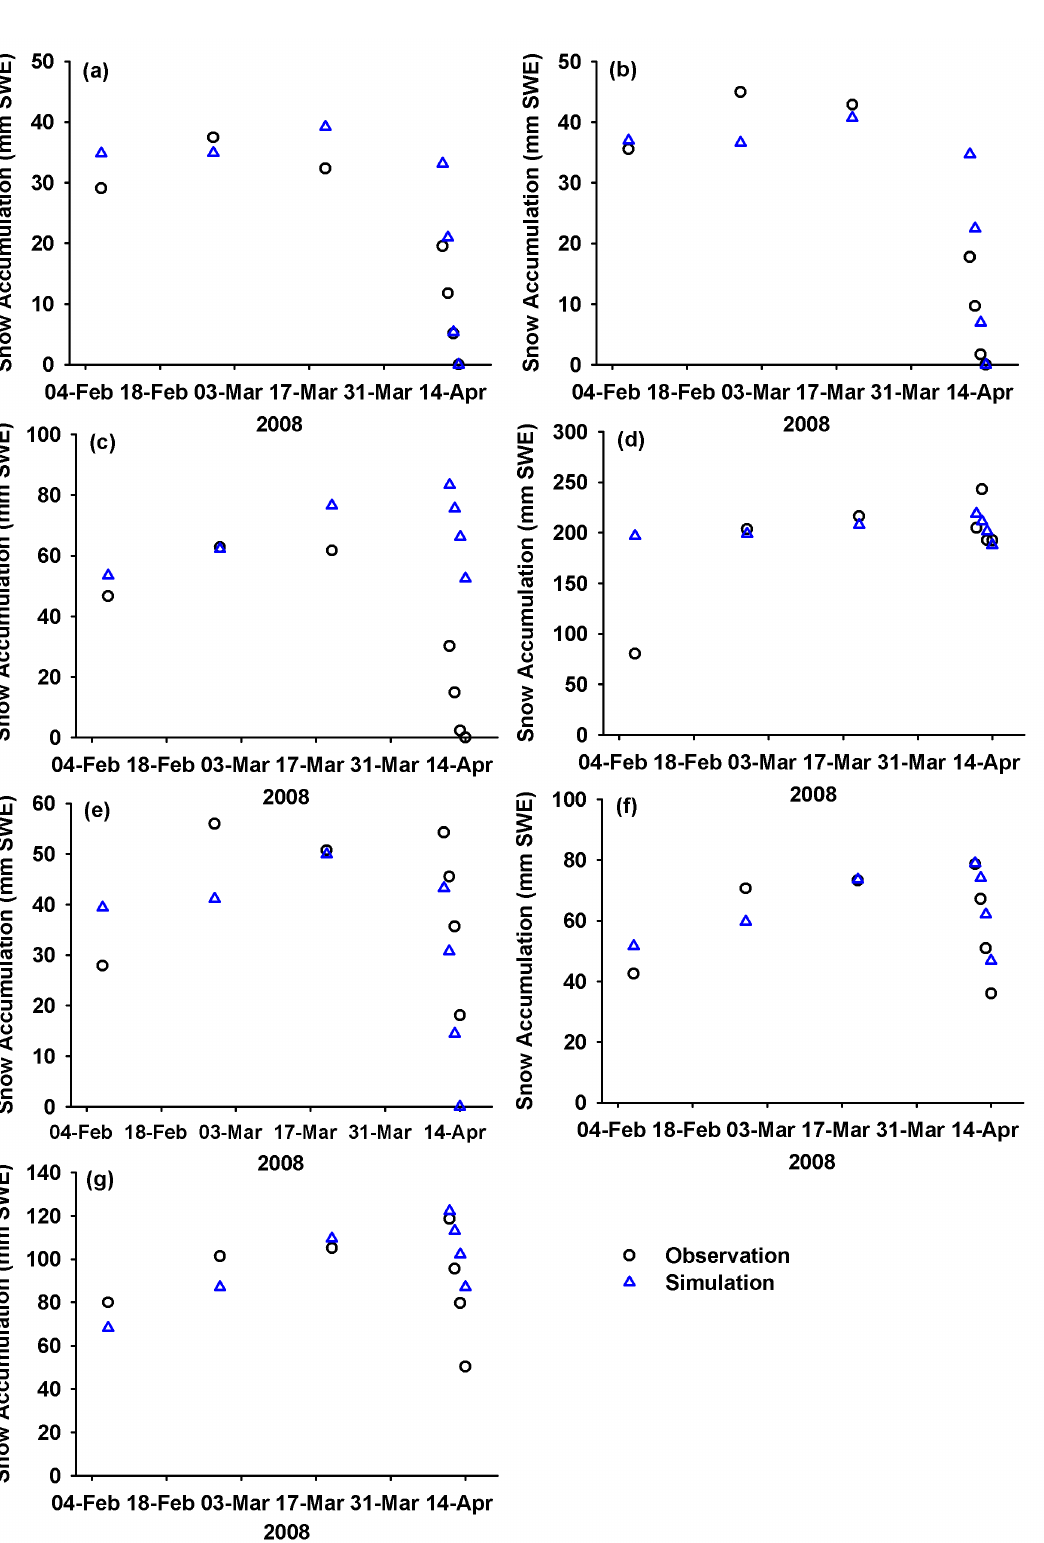
Fig. 7. Comparisons of the observed and simulated snow accumulation (SWE) during 2008 simulation period for seven HRUs in the sub- basin 1 of Smith Creek Research Basin. (a) fallow, (b) stubble, (c) grassland, (d) river channel, (e) open water, (f) woodland, and (g)